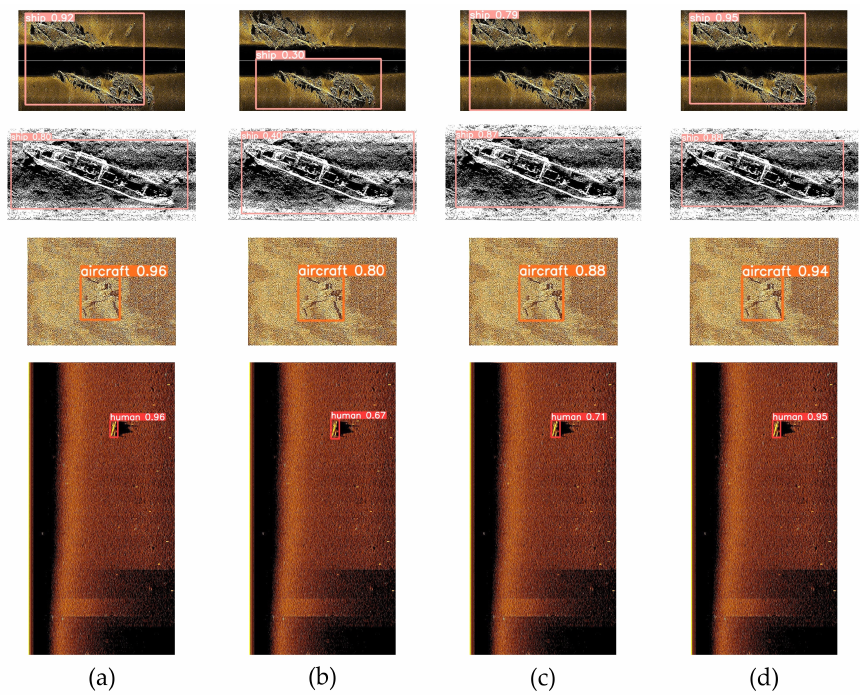
Figure 14. Some representative detection results of four models using Jetson Nano. ( a ) YOLO-slimming; ( b ) YOLOv5-s; ( c ) YOLOv6-s; ( d ) YOLOv7-tiny.